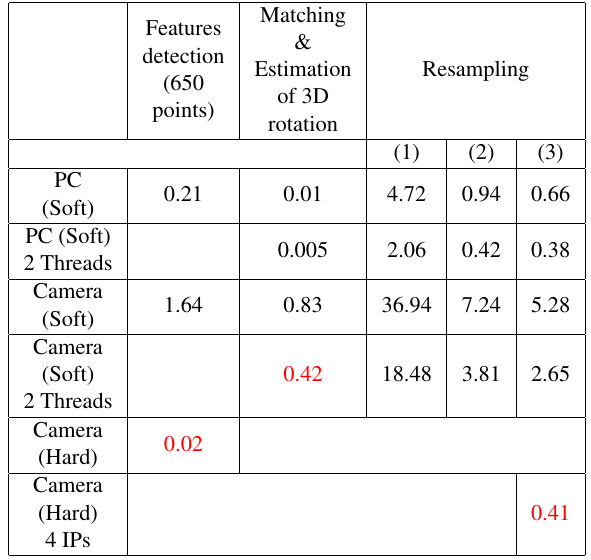
Table 3. (1): geometrical transformation using the 3D rotation and bilinear interpolation, (2): Accelerated geometrical trans- formation with bilinear function method and bilinear interpola- tion, (3): Accelerated geometrical transformation with bilinear function method and Nearest-neighbor